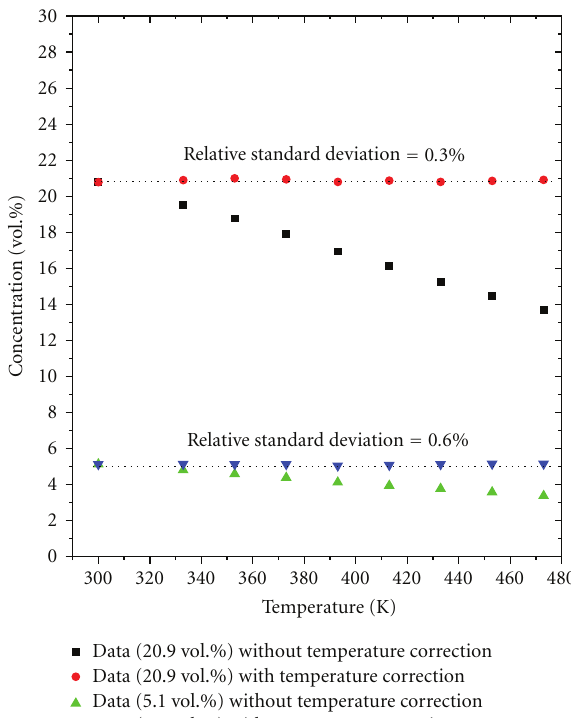
F 6: (Color online) concentration measurement evaluated by scheme C by using atmospheric oxygen and a standard gas mixture containing 5.1 oxygen as the sample gas before and aer temperature correction. %